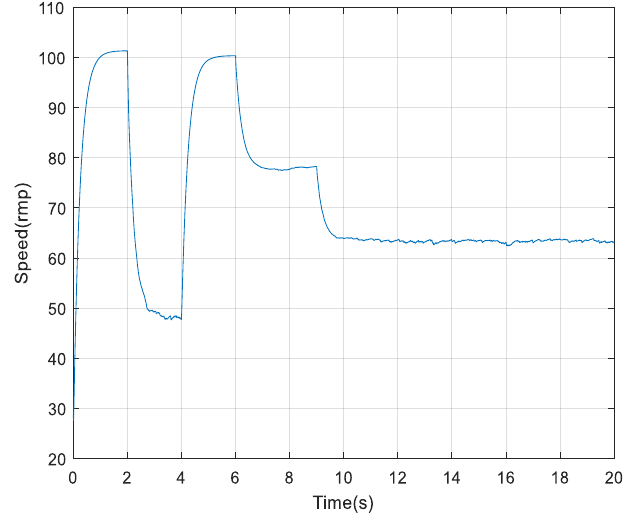
Figure 22. Temporal evolution of the motor speed.